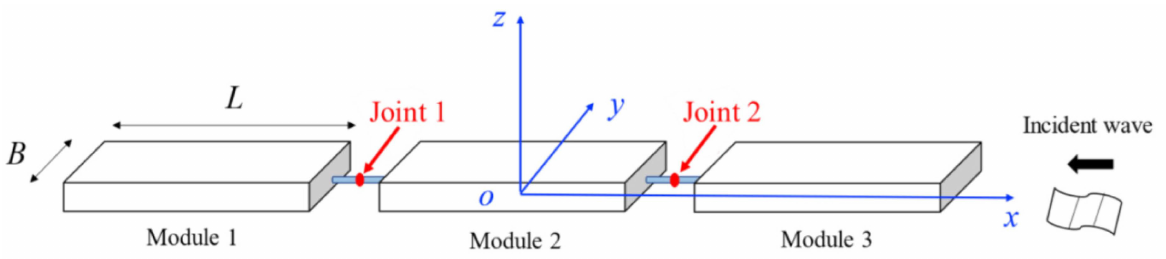
Figure 3. Notation of the three-module hydrodynamic–structural model.